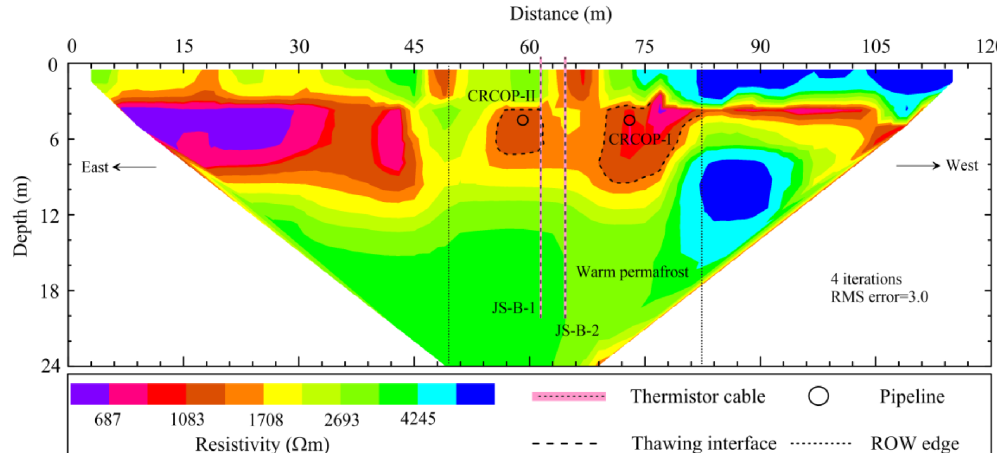
Figure D1. Inversion results of electrical imaging along the P-JS profile at the JS site, carried out in April 2018.